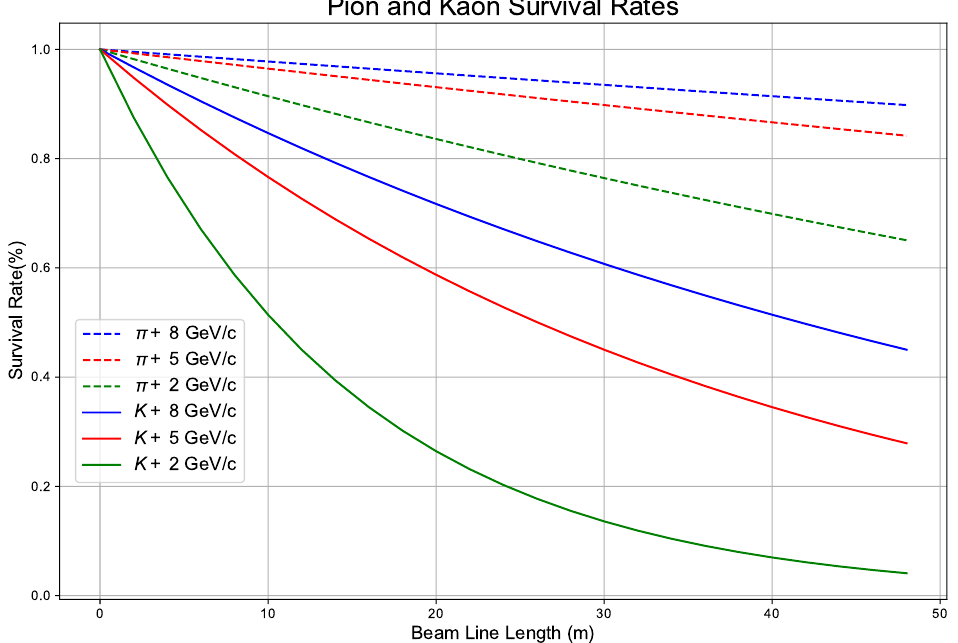
Figure 7. Survival probabilities for low momentum pions and kaons, assuming a beamline with a maximum length of 50